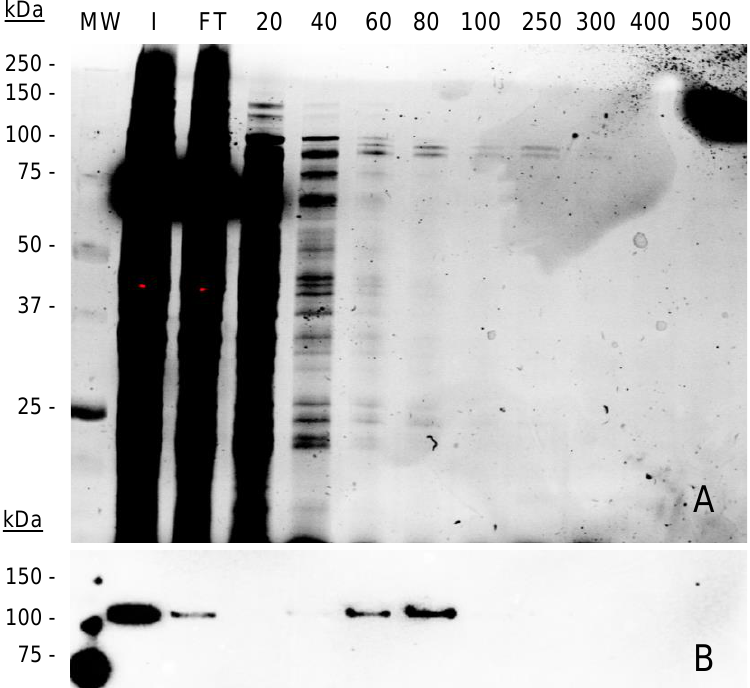
Figure 5. Optimization of conditions for MVP-H6 purification. Purification of MVP-H6 protein with TALON Superflow resin, using different concentrations of imidazol as elution agent. Samples were analyzed by ( A ) SDS-PAGE and TGX visualization, and ( B ) Western blot developed with a monoclonal antibody against His-tag. Legend: initial sample (In), and flowthrough (FT). Numbers 20 to 500 indicate imidazol concentration (mM) used in each step. MW: molecular weight standard.